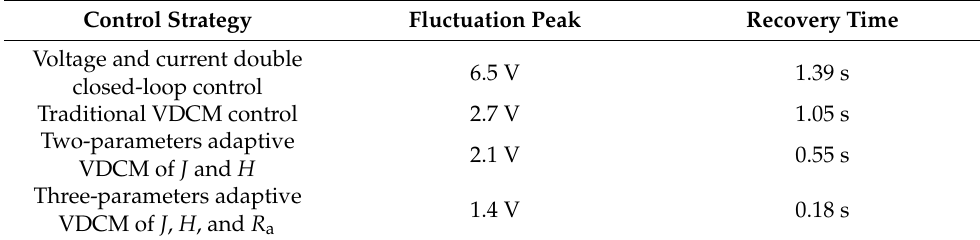
Table 6. Fluctuation peak and recovery time of U o under different control strategies. Control Strategy